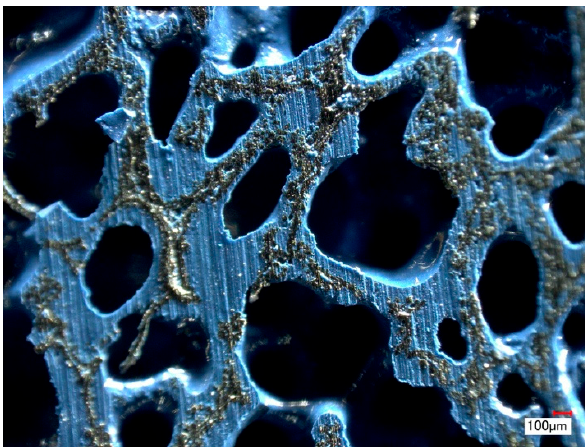
Figure 2. Cross-section of the trailing edge spray-coated by solvent-based paint.